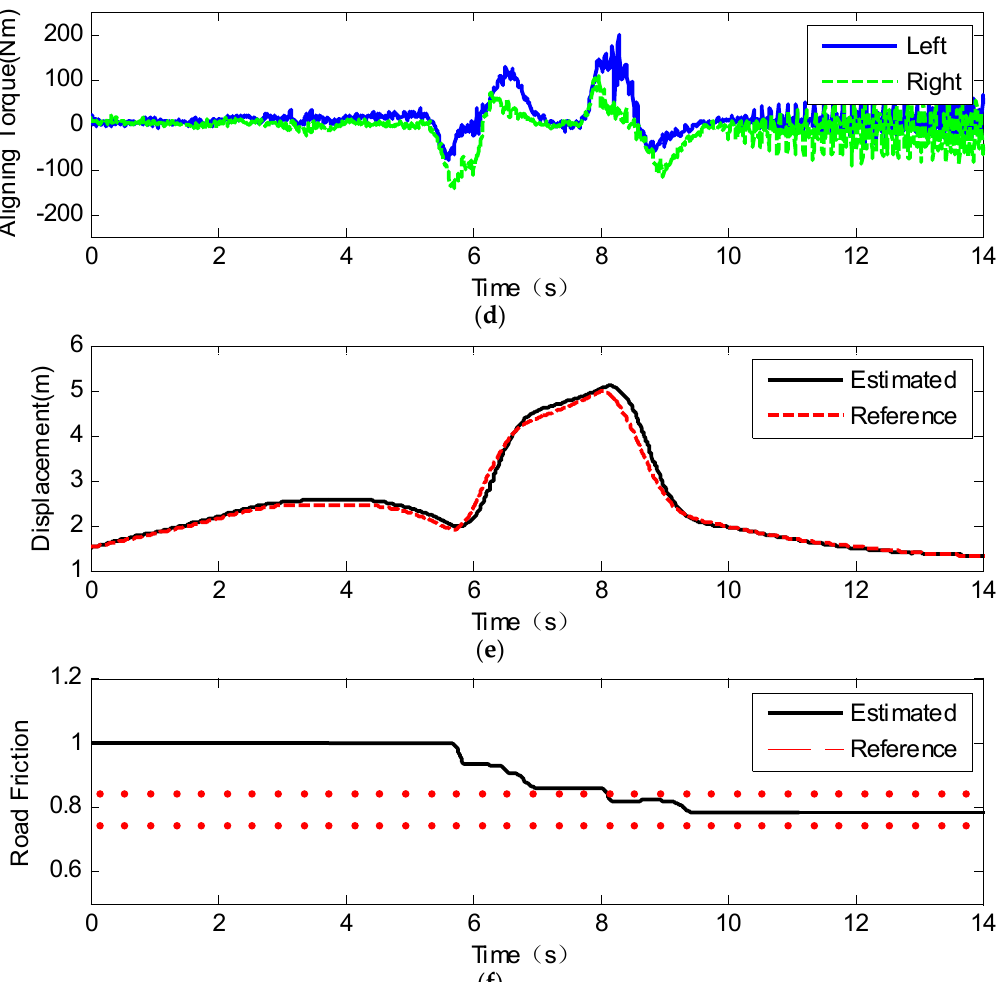
Figure 8. Results of the DLC (Double Line Change) test: ( a ) vehicle speed; ( b ) steering wheel angle and yaw rate; ( c ) longitudinal and lateral acceleration; ( d ) self-aligning torque at the kingpin; ( e ) distance between the vehicle and the left lane line; ( f ) road friction coefficient.